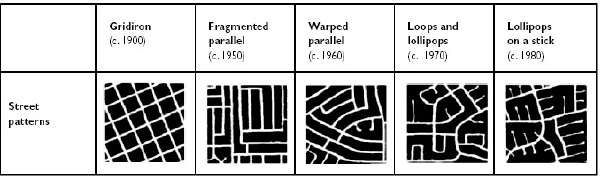
Figure 9. Evolution of street patterns (Southworth and Ben- Joseph 1997)